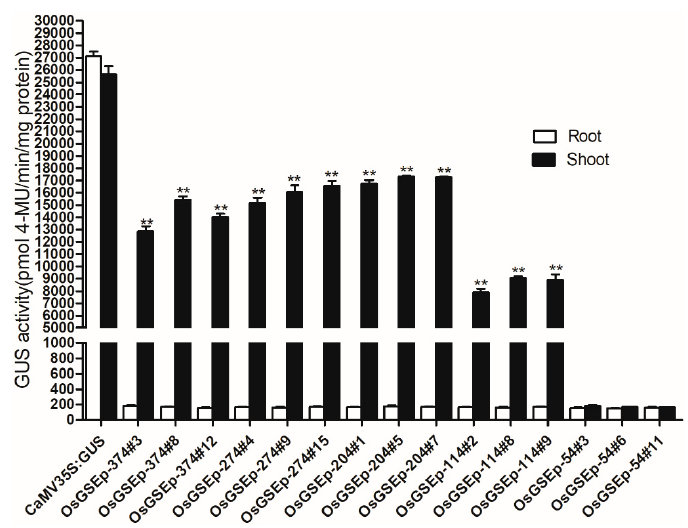
Figure 5. Quantification of GUS activity in transgenic T3 Arabidopsis roots and shoots carrying the CaMV 35S promoter, OrGSEp-374 and different 5 ′ -deletion fragments constructs. Gus activity measurements are shown for three positive transgenic lines for each OrGSEp promoter construct. CaMV35S: GUS is an independent transgenic plant carrying the CaMV35S promoter construct. OrGSEp-374#3, OrGSEp-374#8 and OrGSEp-374#12 are three positive transgenic lines carrying the OrGSEp-374